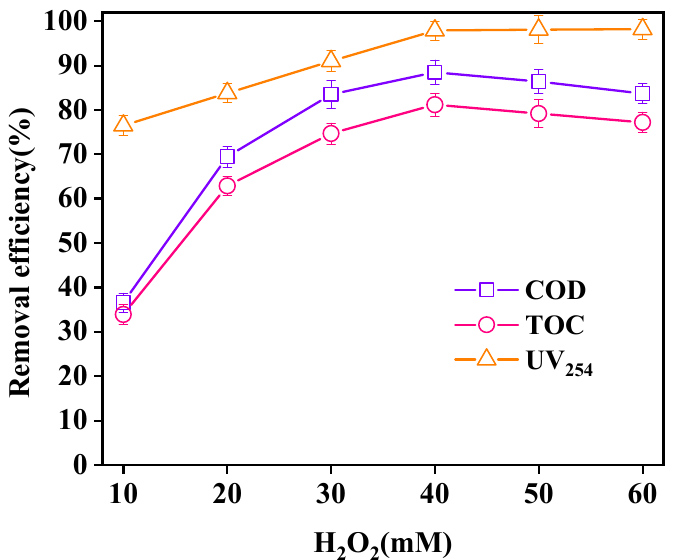
Figure 11. Effect of H 2 O 2 dosage on oxidation. (Reaction conditions: LaCoO 3 /CeO 2 = 0.8 g/L, 120 °C, 1 MPa, 60 min).